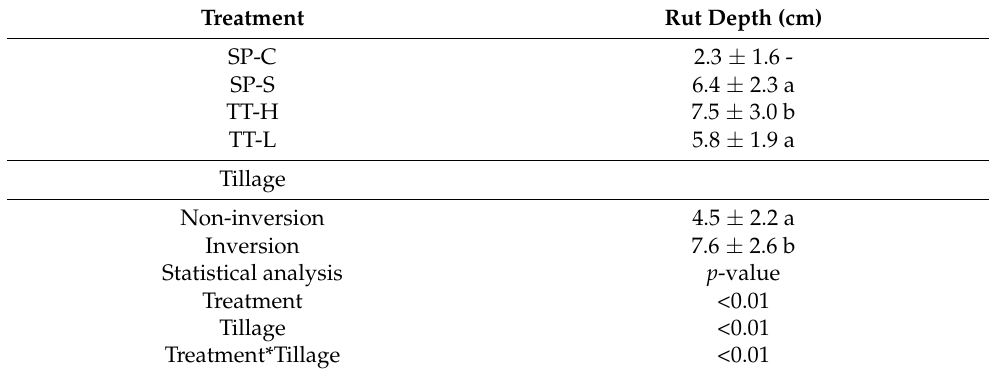
Table 5. Average rut depth (cm) ± standard deviation for the four experimental treatments ( n = 6) and for the two tillage methods (inversion or ploughed and non-inversion) applied in this experiment ( n = 9). The treatment SP-C was kept out of the statistical analysis since it was only measured twice and only in the non-inversion plots. Different letters indicate significant differences ( p < 0.05) for the Tukey post-hoc